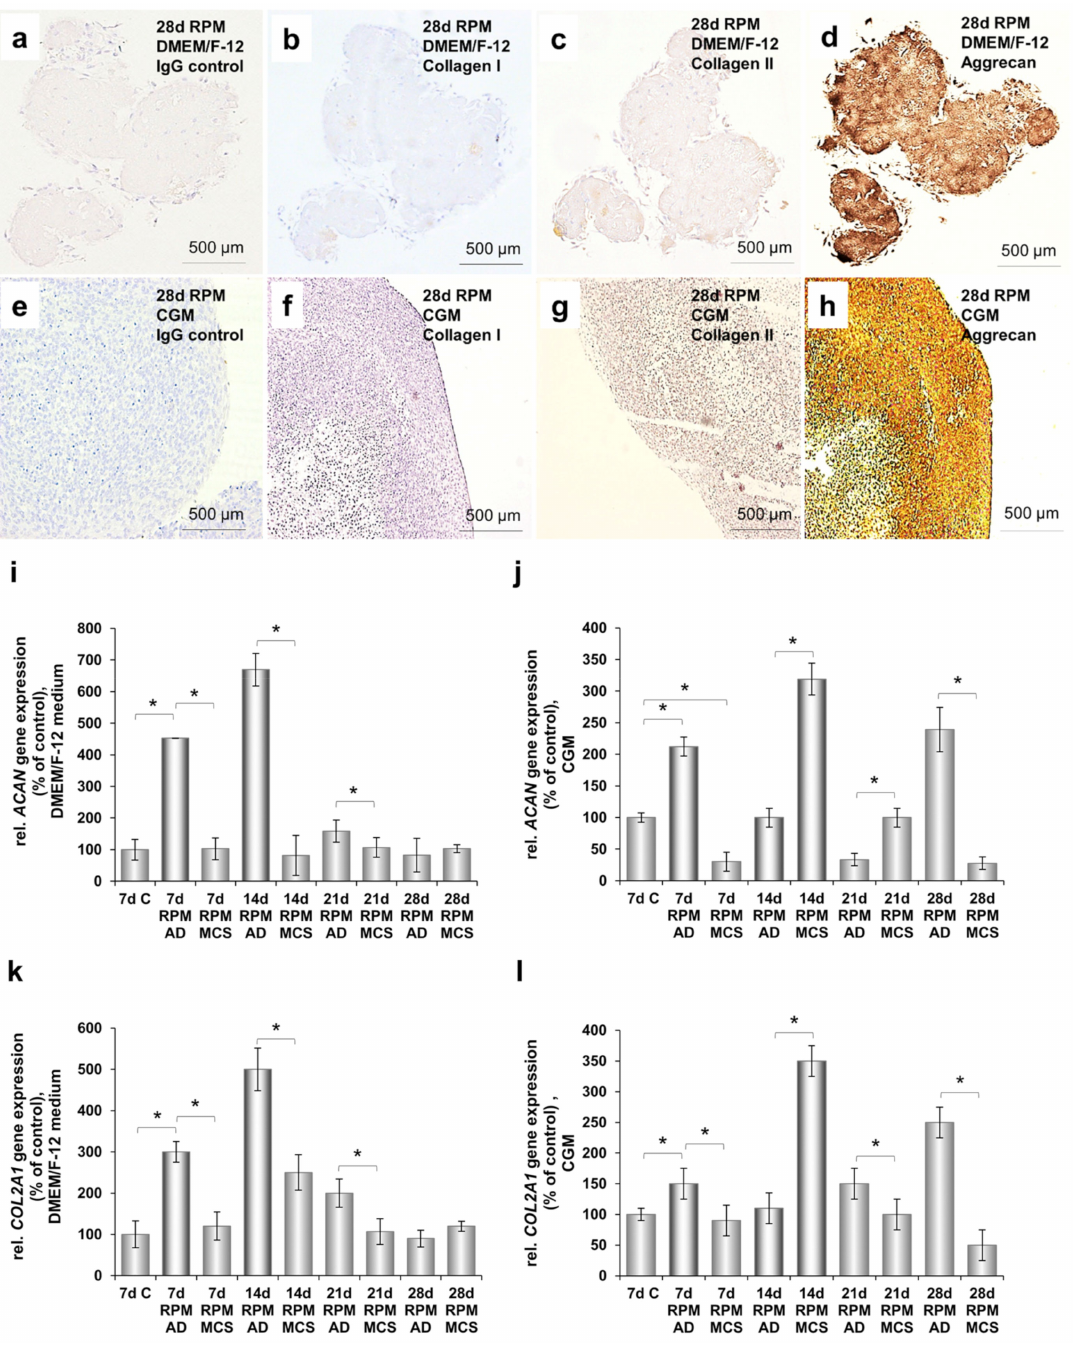
Figure6. Identificationandquantificationofcartilage-specificcomponents, usingimmunohistochemical staining and qPCR analyses. ( a ) Negative control of 28-day-old tissue produced in DMEM / F-12 medium stained only with the secondary antibody. ( b ) Immunohistochemical staining of 28-day-old spheroid produced in DMEM / F-12 medium with monoclonal antibody against collagen type I. ( c ) Monoclonal antibody against collagen type II, ( d ) Monoclonal antibody against aggrecan. ( e ) Negative control of 28-day-old tissue produced in CGM stained only with the secondary antibody. ( f ) Immunohistochemical staining of 28-day-old spheroid produced in CGM with monoclonal antibody against collagen type I, ( g ) with monoclonal antibody against collagen type II, and ( h ) with monoclonal antibody against aggrecan. ( i ) Relative gene expression of aggrecan in 7-day-old chondrocytes cultured under normal gravity conditions (C), and in adherent cells (AD) and tissue (MCS) produced in DMEM / F-12